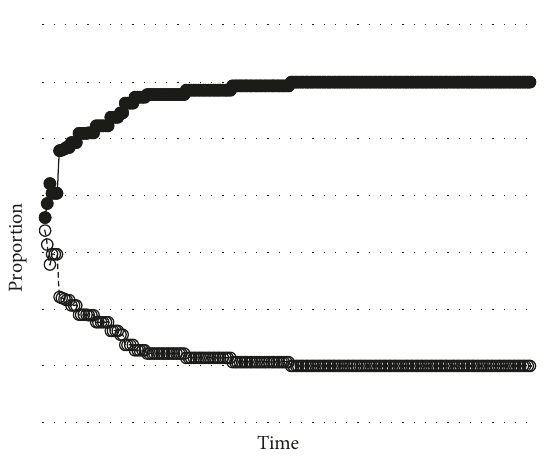
Figure 10: The evolutionary trend of the consumers’ strategy selection with third-party intervention.